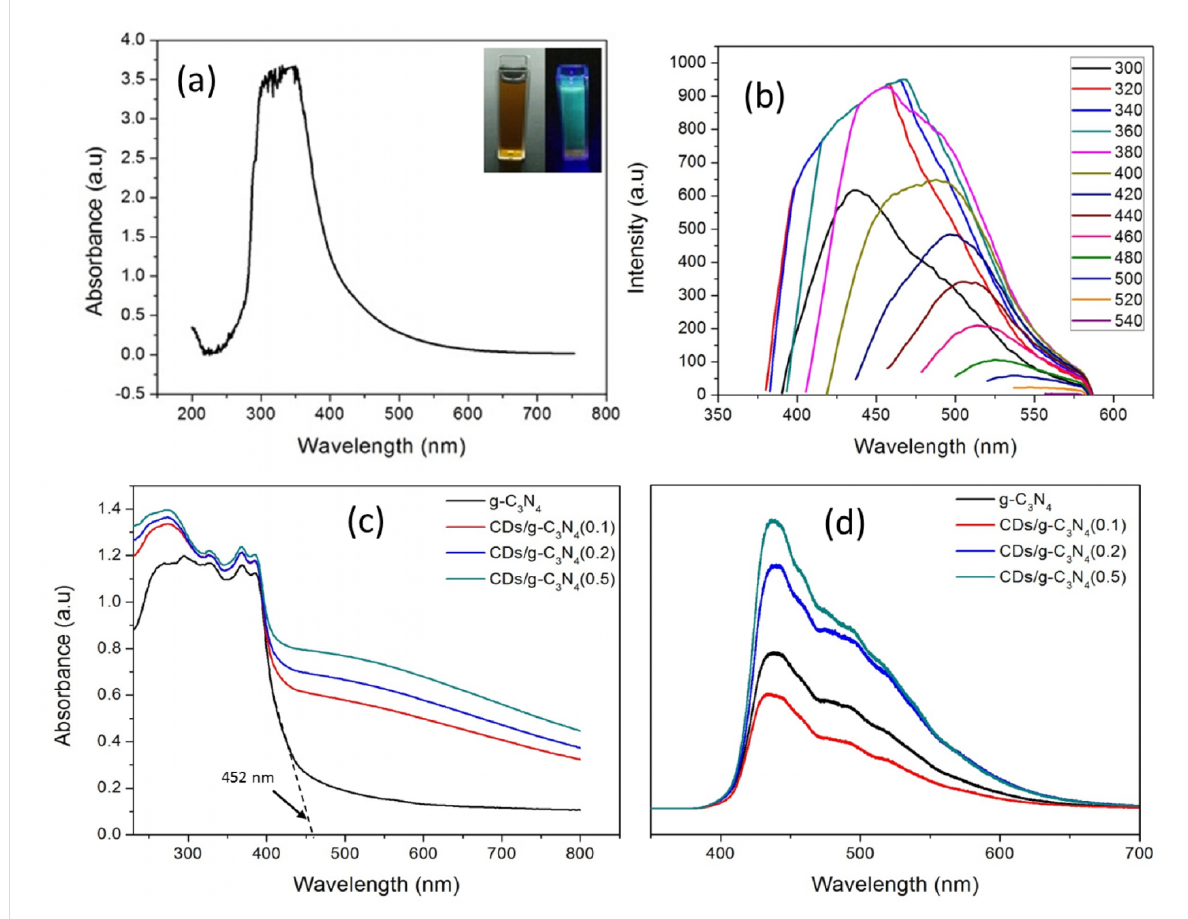
Figure 3: (a) The absorption spectrum of carbon dots (CDs) solution. The inset shows the fluorescence of the CDs under daylight (left) and UV light irradiation at 365 nm (right). (b) The photoluminescence (PL) emission spectrum of CDs at different excitation wavelengths, (c) UV–vis diffuse reflec- tion spectra (DRS) spectra, and (d) PL spectra of the